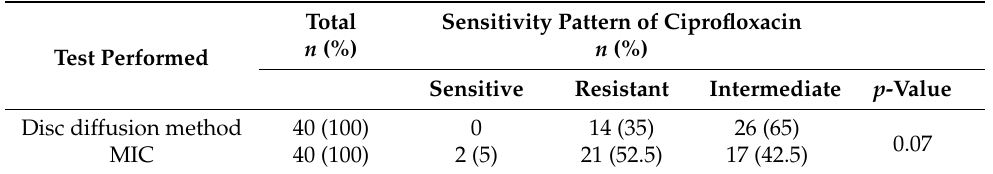
Table 4. Comparison of susceptibility pattern to ciprofloxacin disc diffusion method and ciprofloxacin MIC.